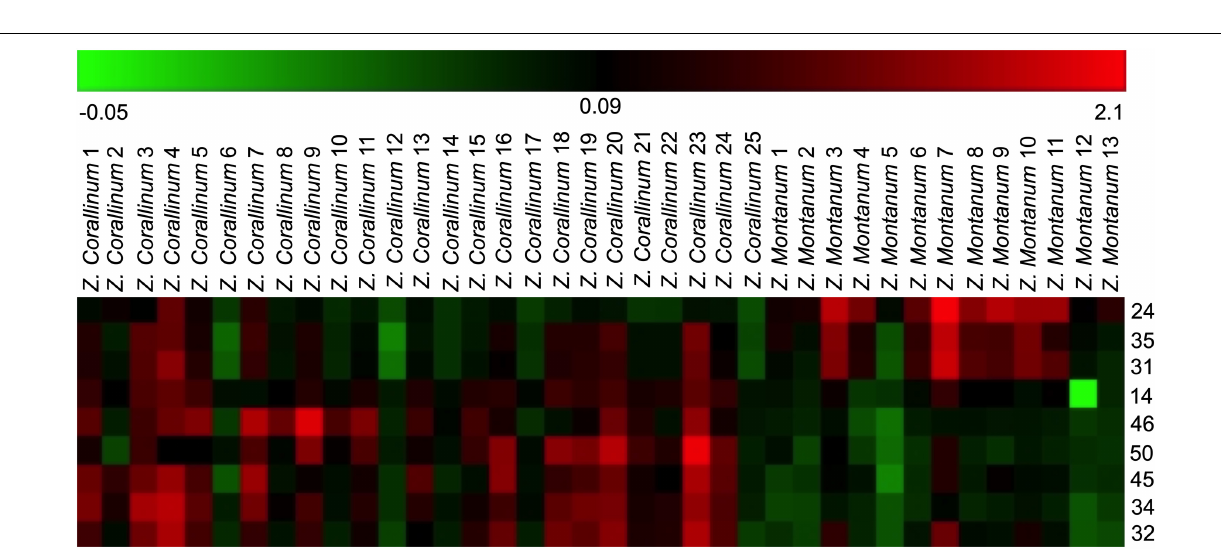
Frontiers in Plant Science |